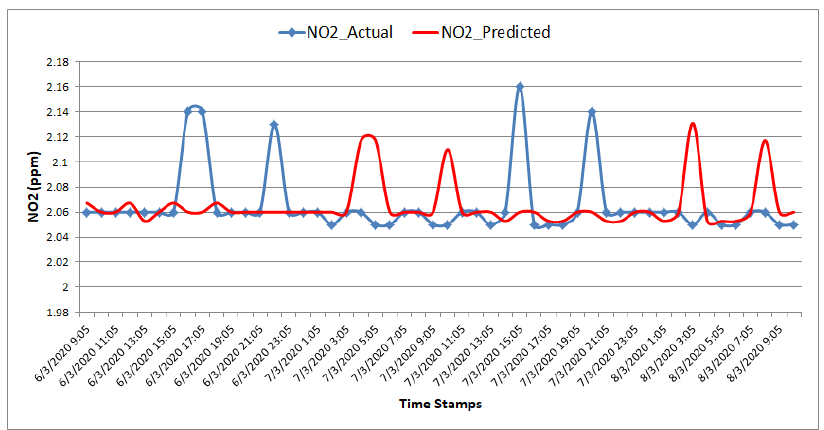
Figure 18. Predicted values of NO 2 vs. Actual values.